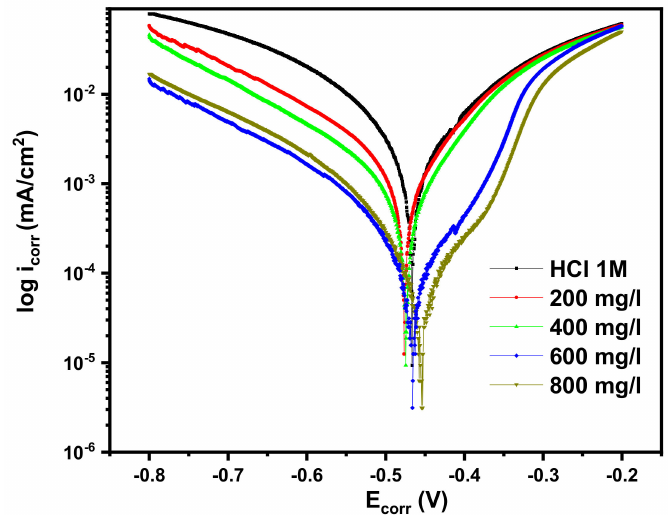
Figure 4. Graphical PDP of corrosion of mild steel (MS) in the absence and presence of Artemisia herba-alba extract CHA.